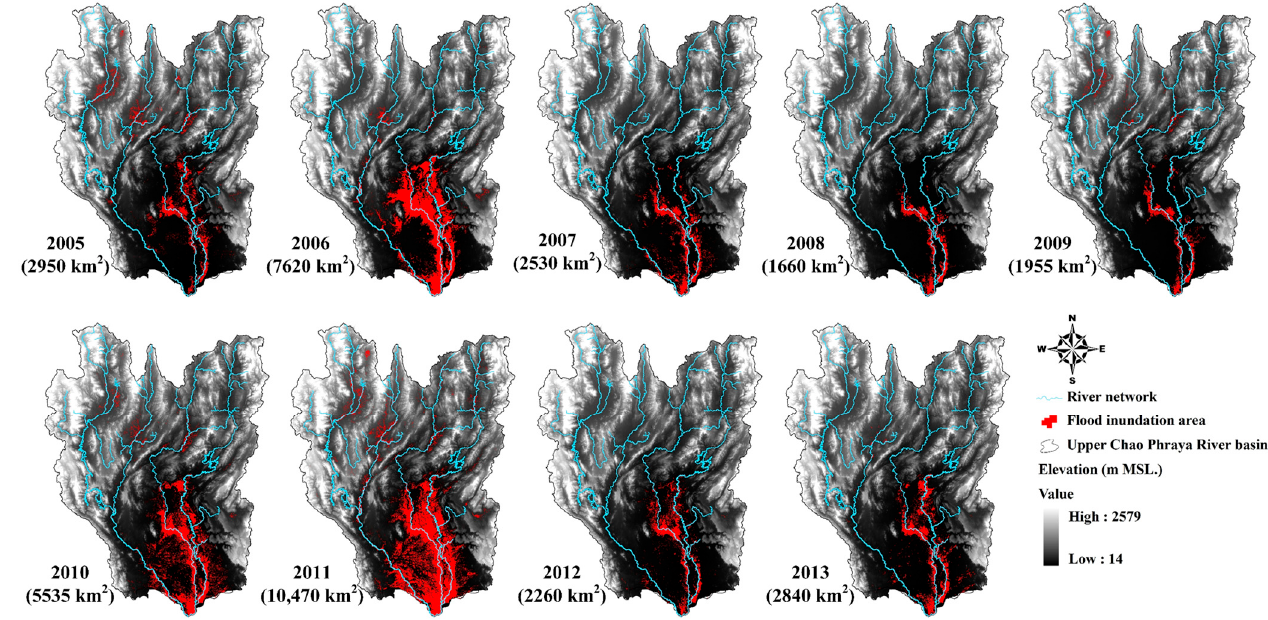
Figure 3. Spatial distributions of annual flood inundation areas (figures in parentheses are in km 2 ).